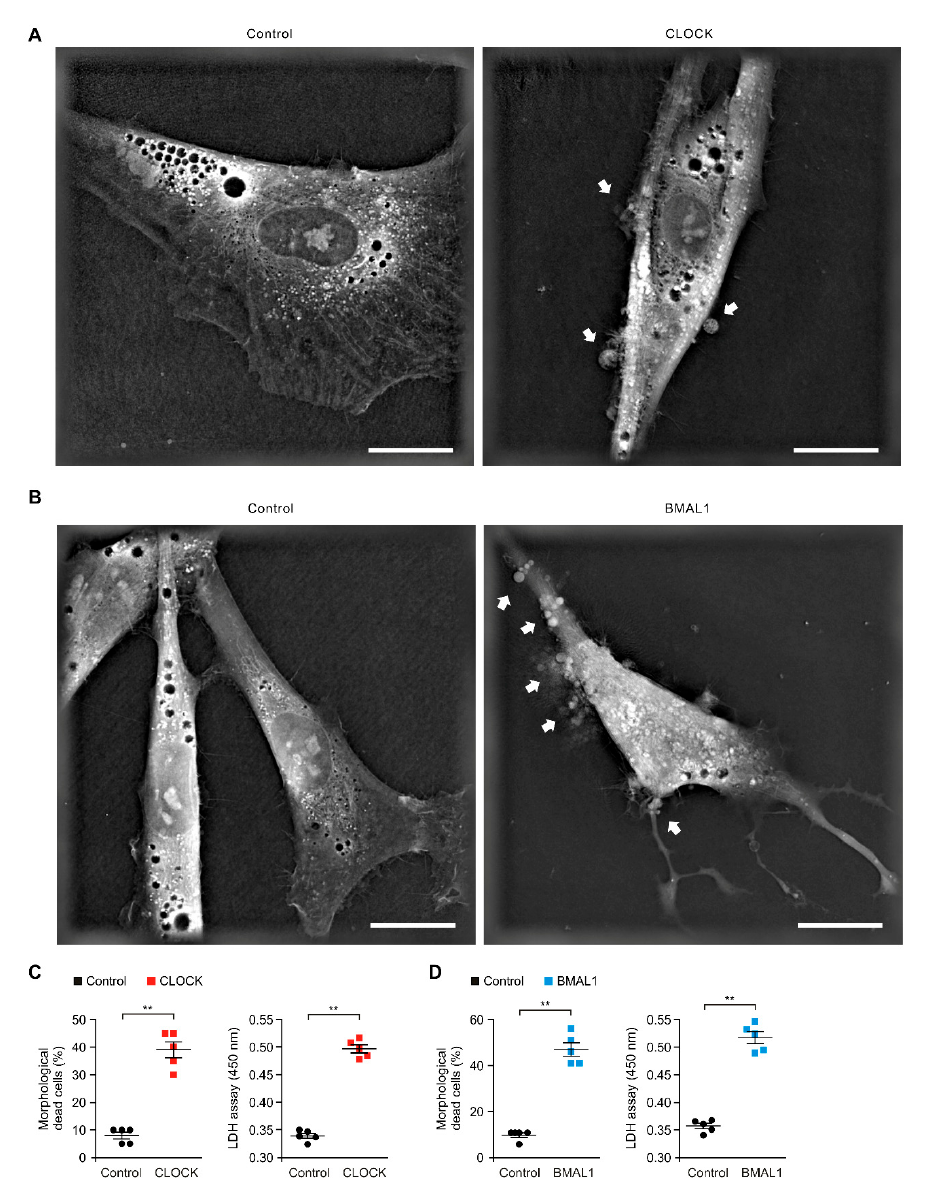
Figure 4. The elevation of CLOCK and BMAL1 induces cytotoxicity in human astrocytes. ( A ) Representative 3D images of control and CLOCK-overexpressing (CLOCK) human astrocytes ( n = 10 images per group). The morphological features of cytotoxicity were indicated (white arrows). Scale bars, 20 µ m. ( B ) Representative 3D images of control and BMAL1-overexpressing (BMAL1) human astrocytes ( n = 10 images per group). The morphological features of cytotoxicity were indicated (white arrows). Scale bars, 20 µ m. ( C ) Quantification of the morphological dead cells (left) in control and CLOCK-overexpressing (CLOCK) human astrocytes (the percent of morphological dead cells in total 100 cells in 10 individual images per group). Cytotoxicity assay (right) in control and CLOCK-overexpressing (CLOCK) human astrocytes using lactate dehydrogenase (LDH) levels. Data are representative of three independent experiments, and each was performed in triplicate. Data are mean ± SEM. ** p < 0.01 using the two-tailed Student’s t -test. ( D ) Quantification of the morphological dead cells (left) in control and BMAL1-overexpressing (BMAL1) human astrocytes (the percent of morphological dead cells in total 100 cells in 10 individual images per group). Cytotoxicity assay (right) in control and BMAL1-overexpressing (BMAL1) human astrocytes using lactate dehydrogenase (LDH) levels. Data are representative of three independent experiments, and each was performed in triplicate. Data are mean ± SEM. ** p < 0.01 using the two-tailed Student’s t